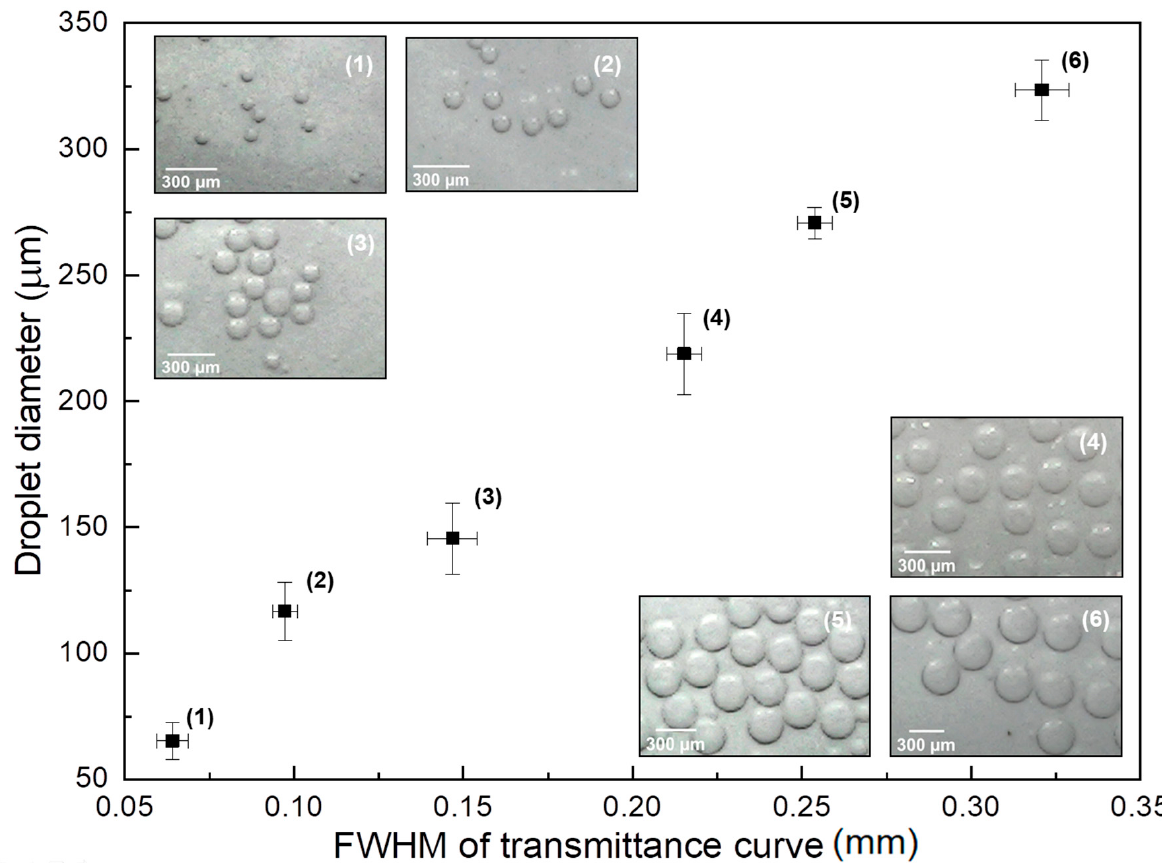
Figure 3. Droplet diameter, measured with optical microscope, as a function of the Full Width at Half-Maximum of the transmittance curves (Figure 2). The numbered insets show optical microscope images of droplets corresponding to each point in the graph.